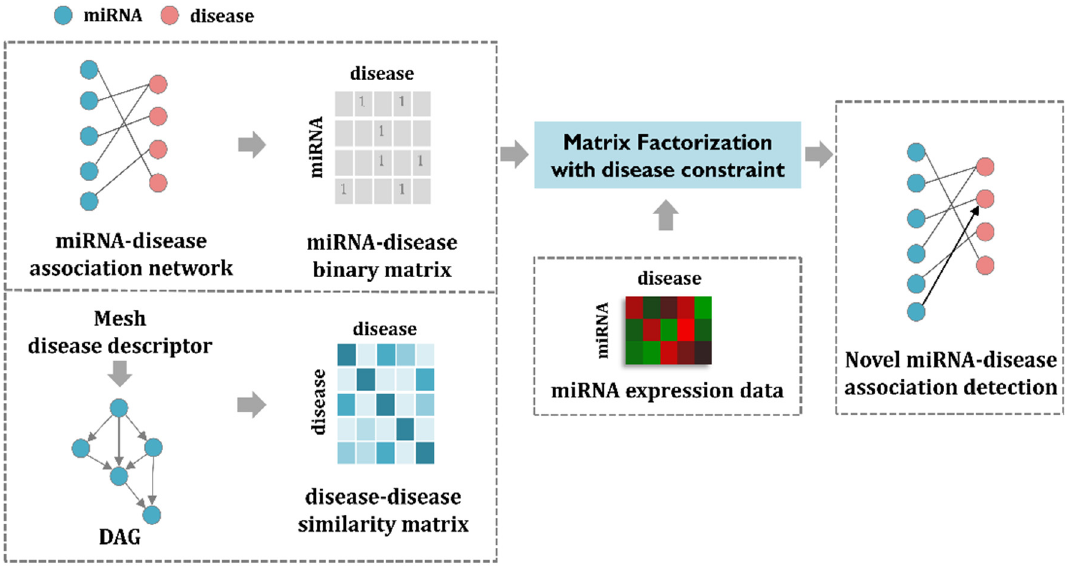
Figure 1. The workflow of MDMF. First, a miRNA–disease association matrix is constructed based on the known miRNA–disease association network. In a similar way, a disease-disease similarity matrix is created through the mesh descriptor. Second, by combining miRNA expression value as a weight for the objective function, the matrix factorization model is efficiently learned. Finally, through the MDMF, each miRNA is given a score for association with a disease, which is used as a basis for making actual predictions.